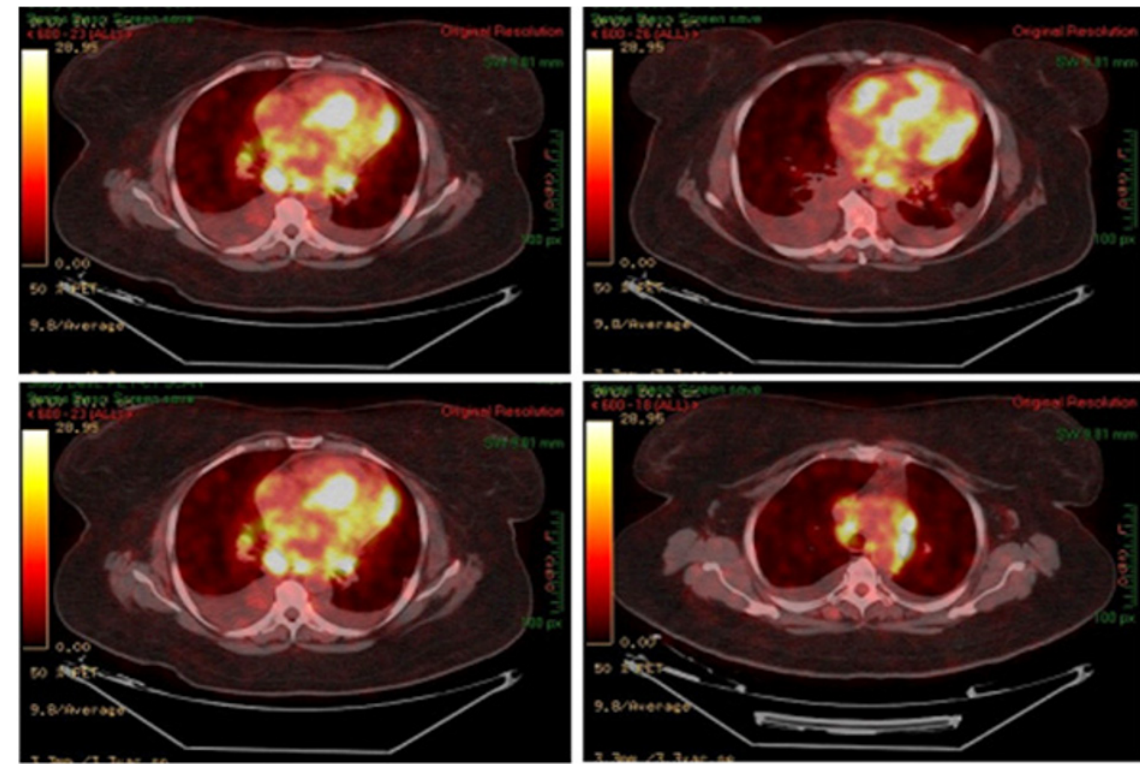
Figure 6. PET/CT shows diffuse 18FDG uptake in the mediastinum, septum and left ventricle.